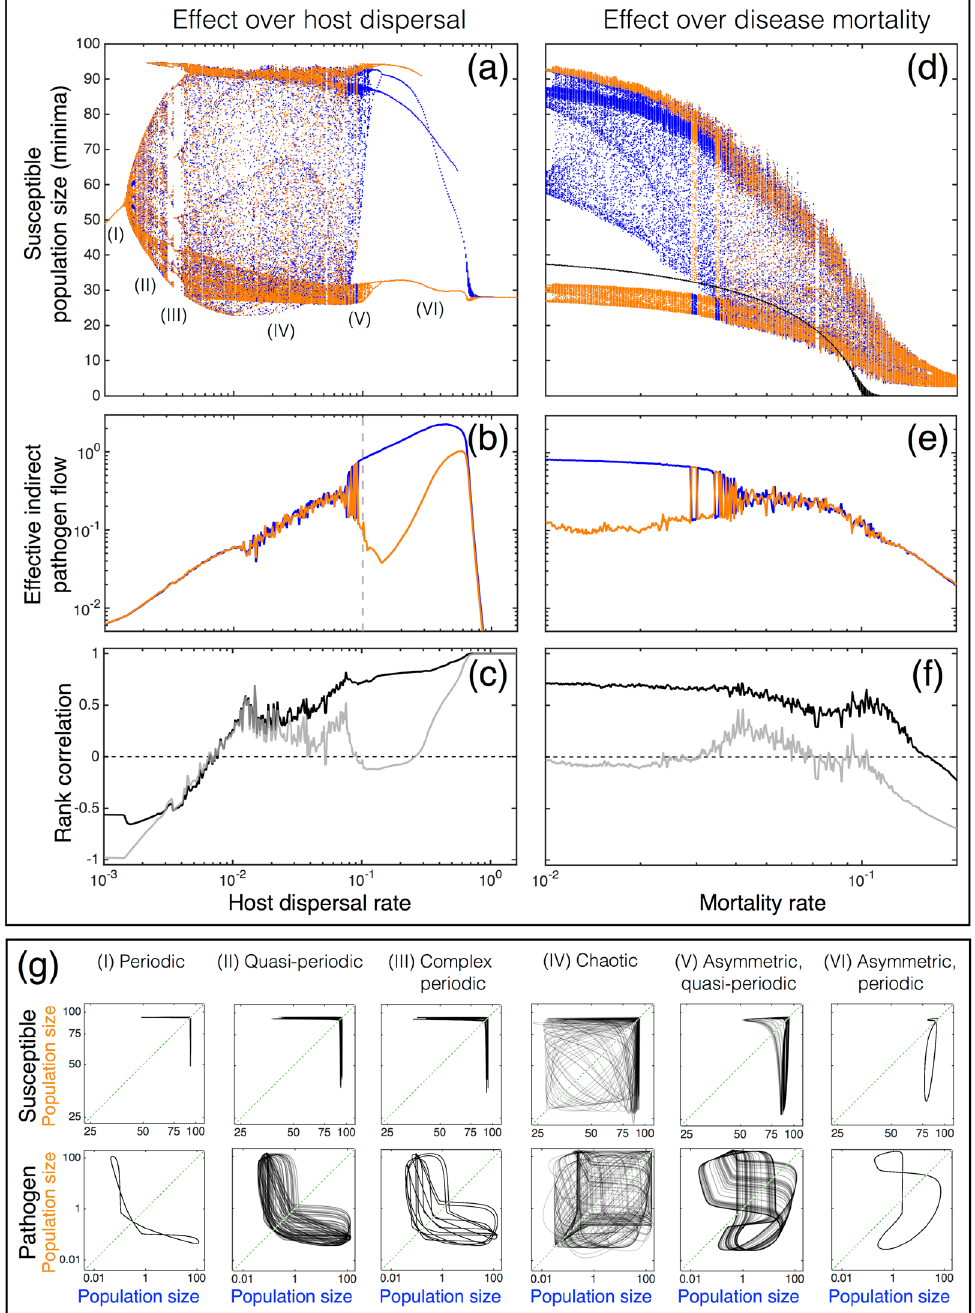
Figure 3. The bifurcation analysis of a chaotic case is presented over host dispersal and mortality rates. ( a , d ) Two bifurcation plots of susceptibles ( κ = 3 and λ = 1). The colour indicates different patches (blue and orange). In ( d ), black points represent the bifurcation plot of a double-sized one-patch system (comparable host population size) showing extinction under a lower mortality rate than an asynchronous two-patch system. The next row ( b , e ) represents effective indirect pathogen flow caused by immigrating infected hosts. A dotted vertical grey line on ( b ) shows the host dispersal value (0.1), fixed in ( e ). Panels ( c , f ) show synchronization between the patches for susceptibles (black line) and for the pathogen populations (grey line). Panels ( a – f ) are computed using the same parameter values and therefore they show different aspects with respect to the same runs. ( g ) Attractors of the susceptible and the pathogen for different dynamical scenarios indicated in panel ( a ). Label colors match with patch colors. Along increasing host dispersal, the system starts from periodic dynamics (I), moves to quasi-periodic behavior (II) and after that follows chaotic dynamics (IV). As the pressure of indirect pathogen flow further increases the system becomes first asymmetric, quasi-periodic (V) and then asymmetric, periodic (VI). Complex periodic dynamics (III) take place in bifurcation diagrams during phase- locking periods (the behavior of a system becomes occasionally